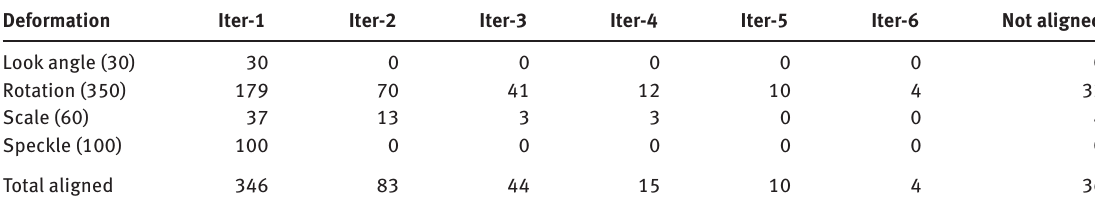
Table 4: Iteration (Tilt) Analysis: Total Number of Aligned SAR Images Deformation and Iteration/Tilt Wise. Deformation Iter-1